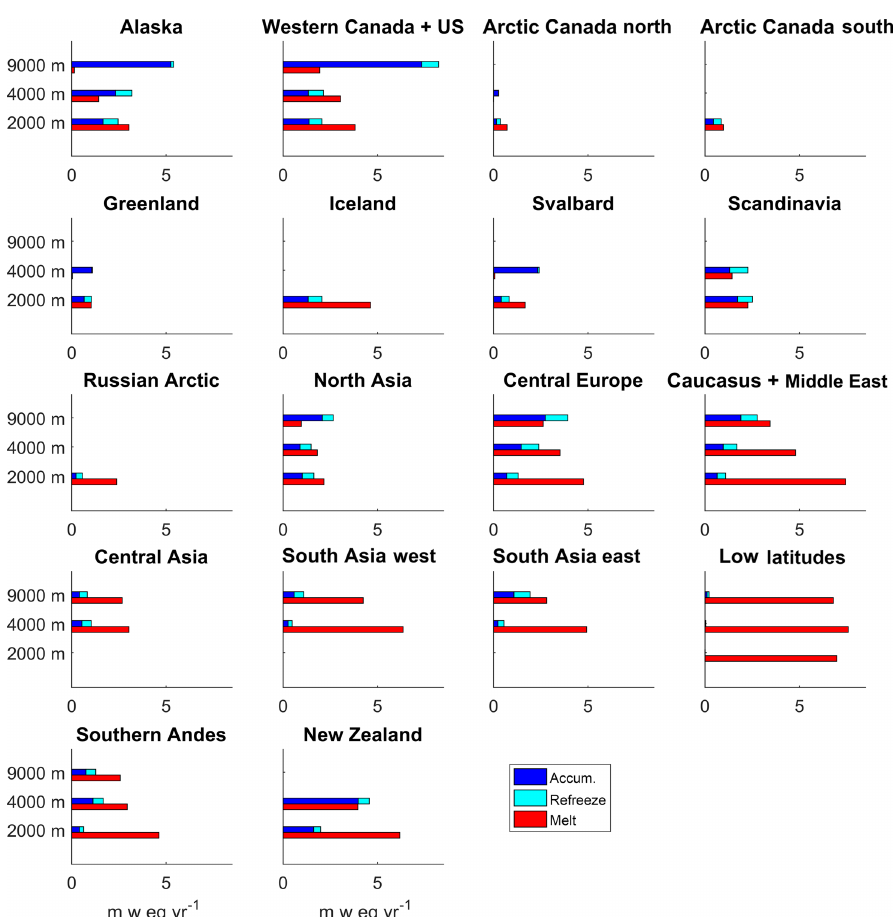
Figure 12. Modelled annual surface mass balance components: accumulation, refreezing, and melting for the period 1980–2000 for RGI6 regions. To make the figure easier to read, melting is given as a positive sign and sublimation is excluded because its contribution is